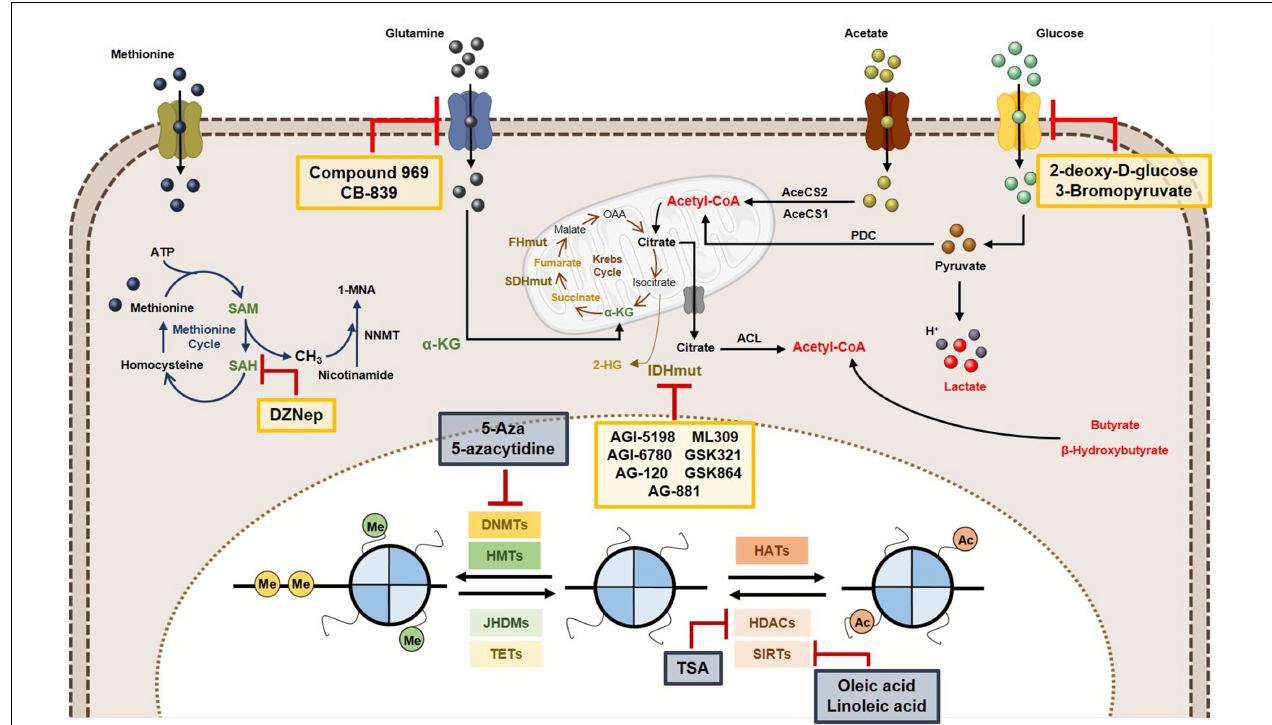
FIGURE 6 | Metabolic and epigenetic targeting inhibitors. Yellow box represents the inhibitors targeting tumor cell metabolism. Blue box are representative of epigenetic enzymes inhibitors. Abbreviations: 2-HG, 2-hydroxyglutarate; AceCS1, acyl-CoA synthetase short-chain family member 1; AceCS2, acyl-CoA synthetase shirt-chain family member 2; ACL, ATP-citrate lyase; DNMTs, DNA methyltransferases; FHmut, fumarate hydratase mutant; HATs, histone acetyltransferases; HDACs, histone deacetylases; HMTs, histone methyltransferases; IDHmut, isocitrate dehydrogenase mutant; JHDMs, Jumonji-C domain-containing